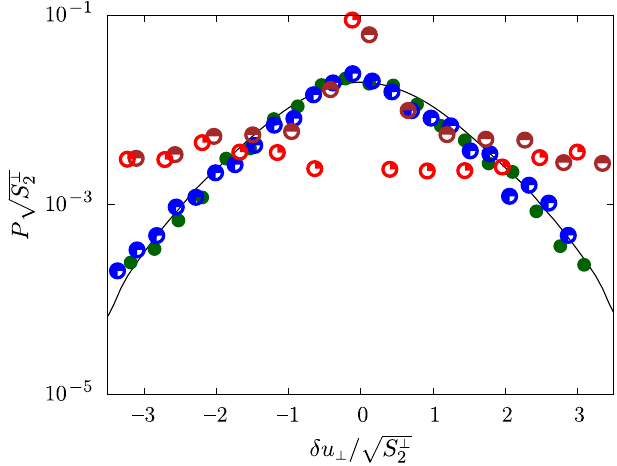
FIG. 4. PDF of the transverse velocity difference for fiber length (or separation distance) c=L ¼ 0 . 16 . The bullets corre- spond to the four different fiber linear densities reported in Fig. 1, while the black solid line is the Eulerian PDF.